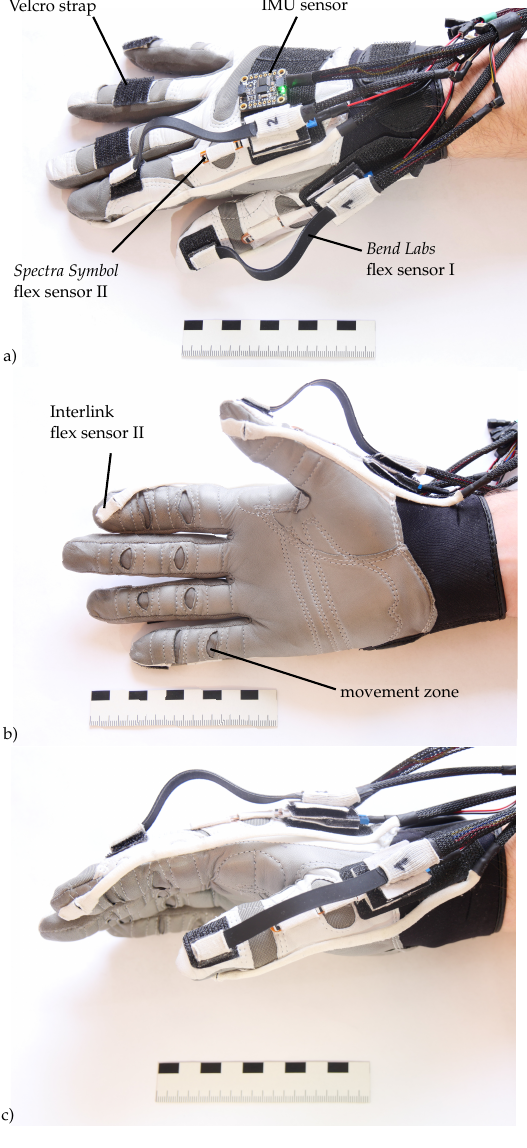
Figure 5. Final realization of SenGlove for a medium-sized right hand with two fingers equipped with sensors. a) dorsal view. b) palmar view. c) lateral view.